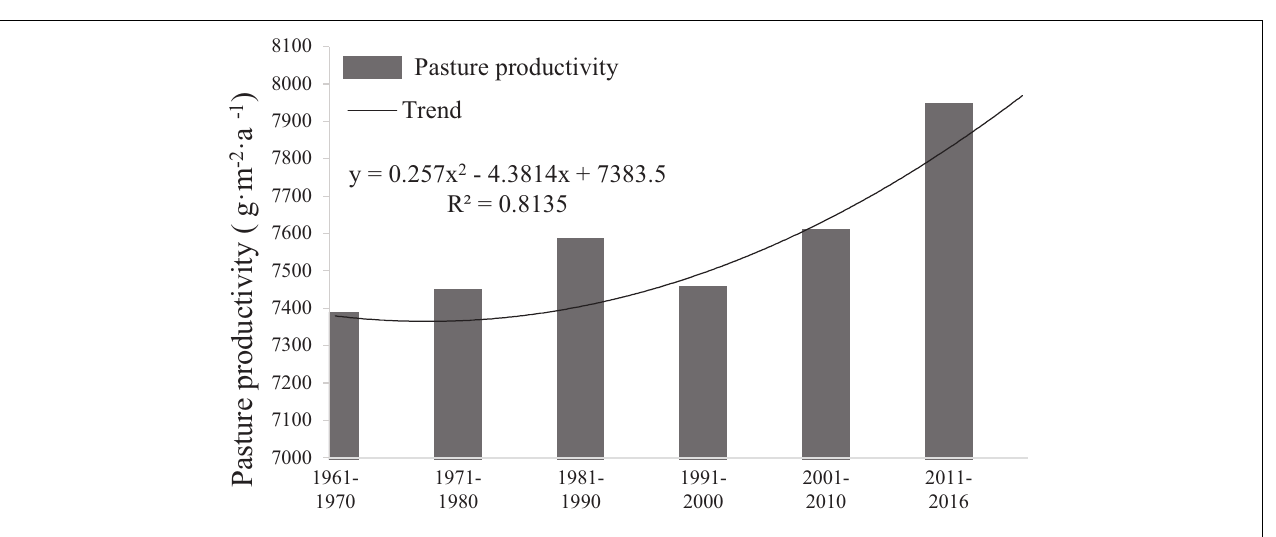
y = 0.257x 2 - 4.3814x + 7383.5